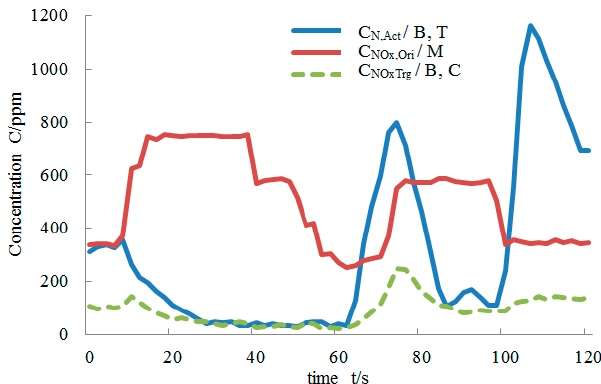
Figure 5. NO x emissions in dynamic conditions before the correction.